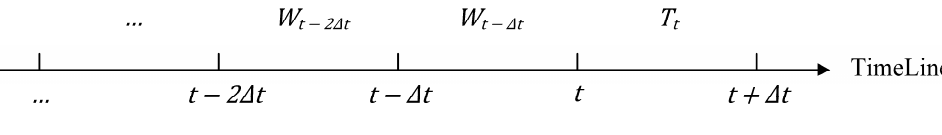
Figure 4. Time slicing for queuing time estimation and prediction.